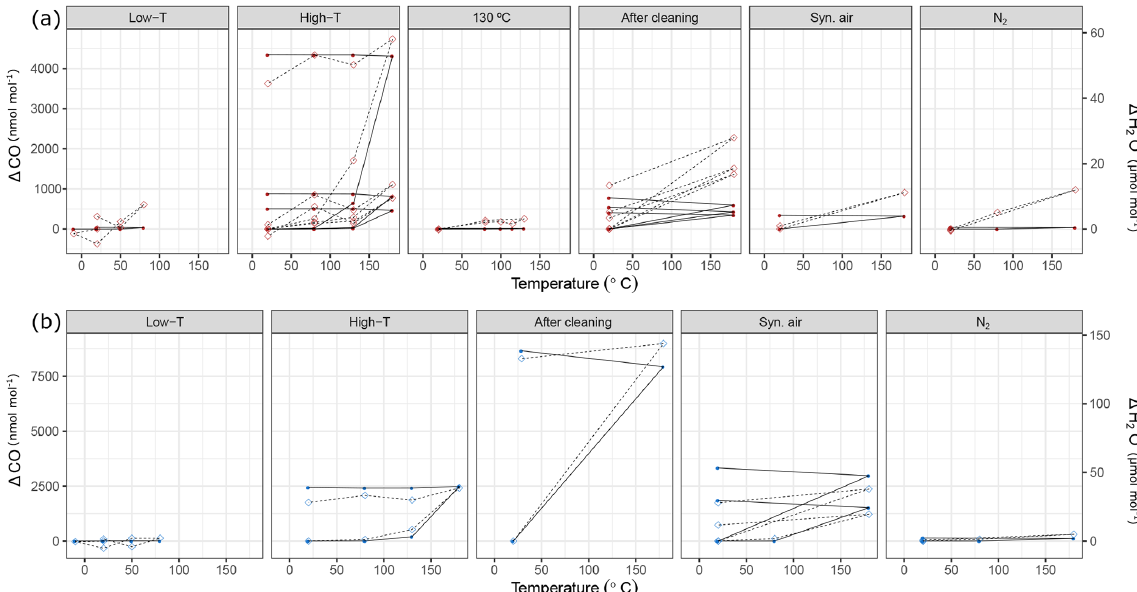
Figure 10. Temperature experiments using (a) steel (red) and (b) aluminum (blue) cylinder in chronological order for species CO and H 2 O. Filled circles correspond to the left y axis (CO), whereas open diamonds correspond to the right y axis (H 2 O). See Table 1 for details of the temperature cycles. In each subplot, temperature cycles are connected with solid lines for CO and with dashed lines for H 2 O. The y axes quantify the differences from the amount fractions measured at 20 ◦ C ( (cid:49) CO and (cid:49) H 2